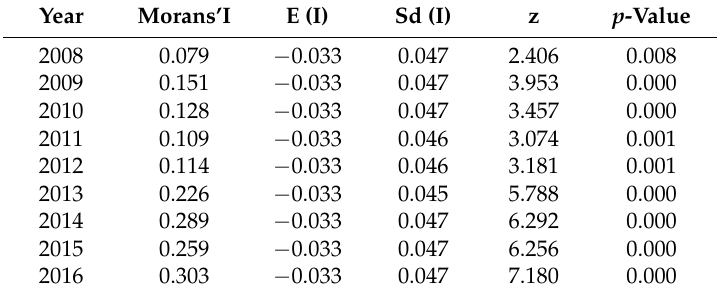
Figure 4. Identification for spatial correlation of OLS estimation error. Note: *** mean p < 0.01. Table 5. Global Morans’ I indicators for PM 10 in 30 provinces in China during 2008–2016.